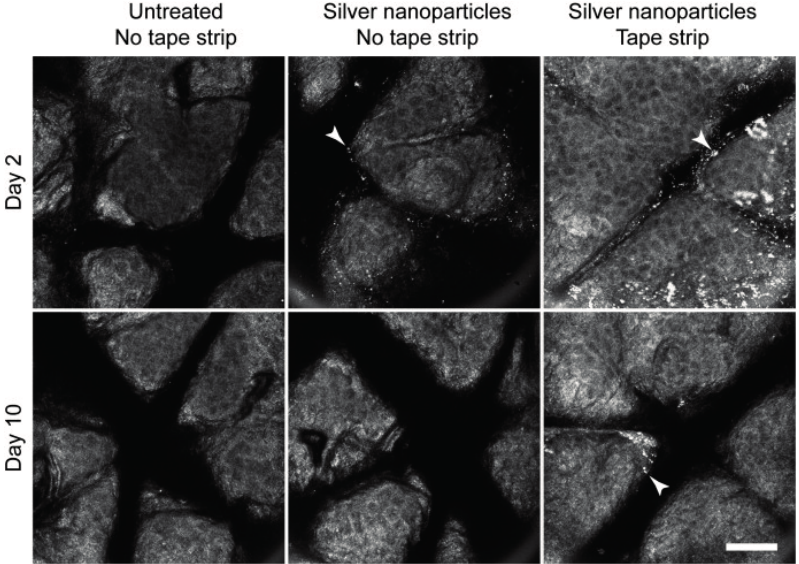
Figure 2. In vivo , en face reflectance confocal sections of human skin applied with ZnO-NP. Silver nanoparticles, indicated by white arrowheads, were seen aggregating on the skin surface for up to 6 days (data not shown) in intact skin and up to 10 days in barrier-disrupted skin. The white bar represents 200 µm. Reproduced with permission from [15], published by Elsevier B.V.,